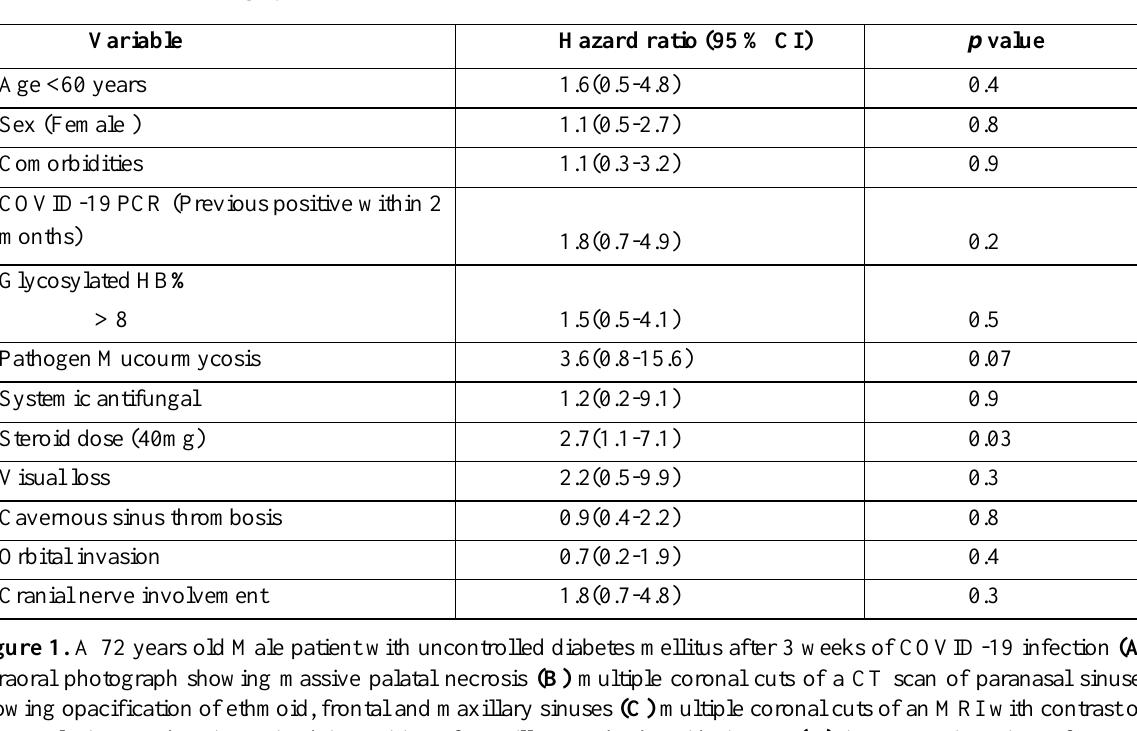
Table 4. Univariate Cox proportional hazards regression of the association between invasive fungal sinusitis survival and clinical and sociodemographic factors.